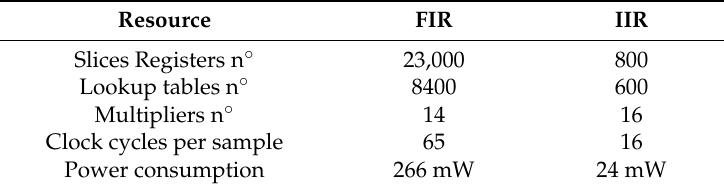
Table 1. Hardware resource utilization for FIR and IIR filters from Xilinx VIVADO ® .